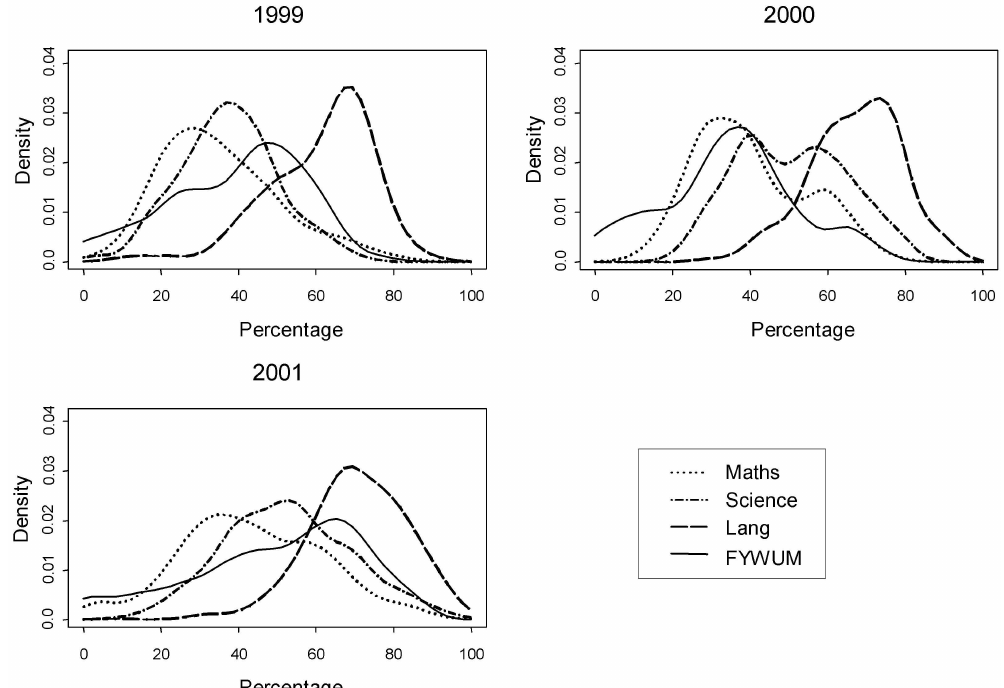
Figure 2: Kernel density estimates of the densities associated with the access test variables and the FYWUM of the Test Battery 1 data sets for 1999, 2000 and 2001.